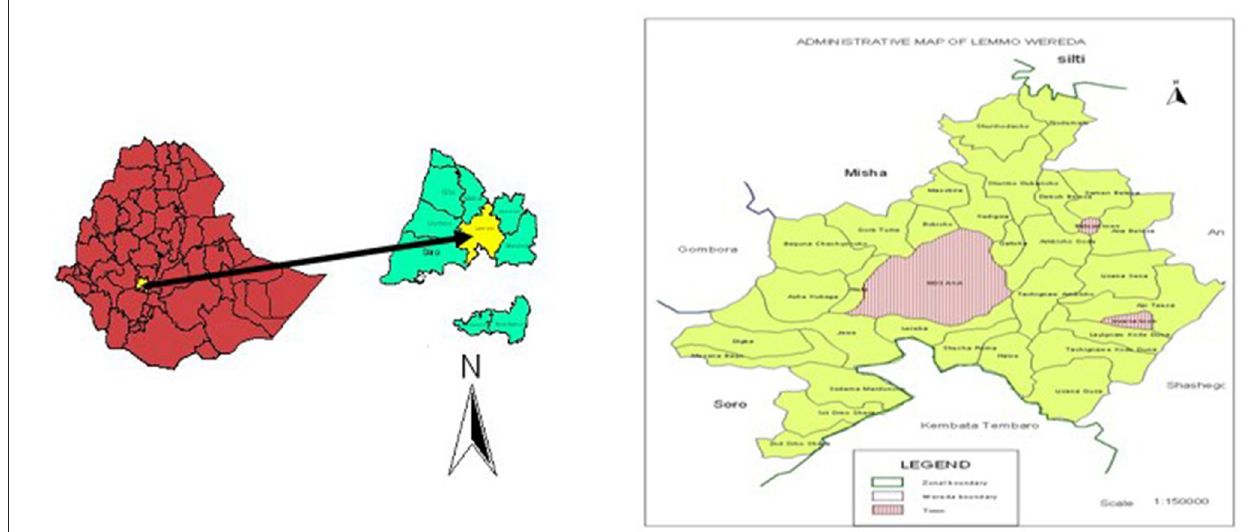
FIGURE 1 | Location of Hadiya zone and study area Lemo Woreda in